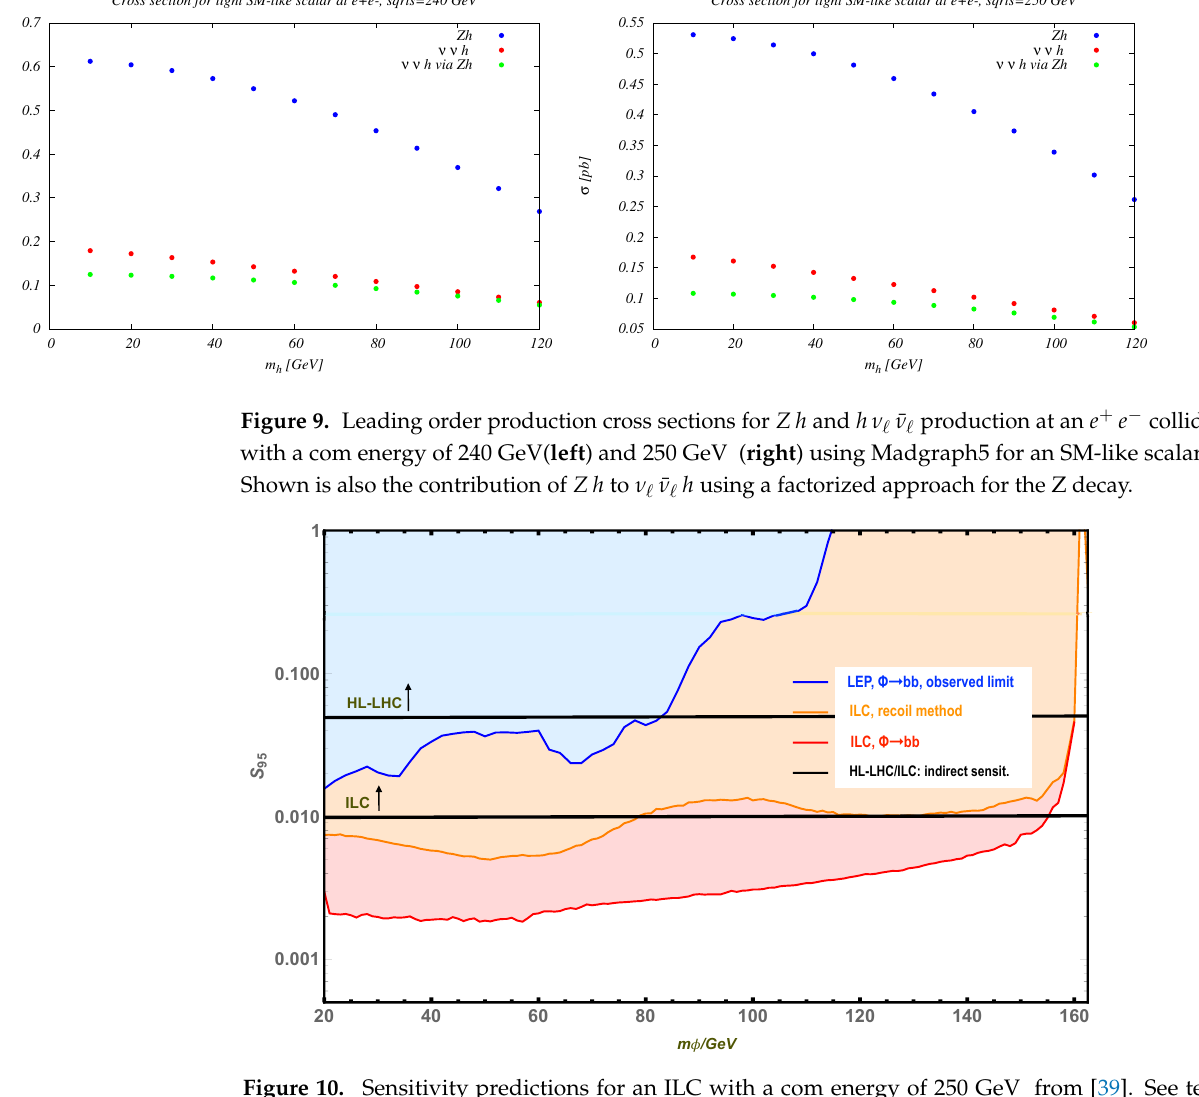
Figure 10. Sensitivity predictions for an ILC with a com energy of 250 GeV from [39]. See text Figure 2: combined limits at 95% CL, 500 fb ≠ 1 @ 250 GeV for